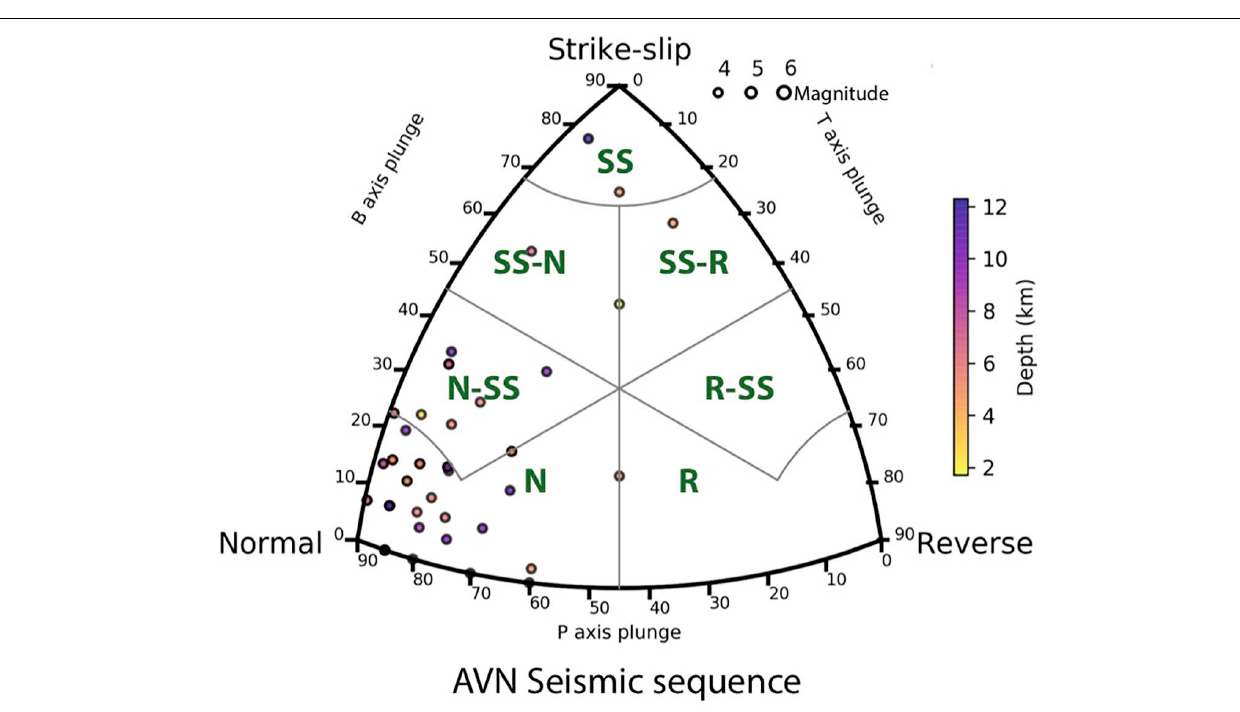
FIGURE 14 | FMC diagram for the classification of focal mechanisms AVN area. N, normal; N-SS, normal–strike-slip; SS-N, strike-slip–normal; SS, strike-slip; SS-R, strike-slip–reverse; R-SS, reverse–strike-slip; R, reverse. The points are scaled by magnitude and colored by different depths.